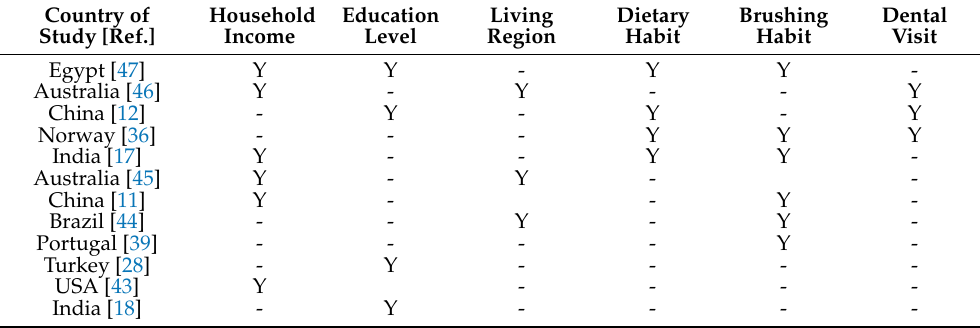
Table 5. Socioeconomic and behavioural factors related to caries assessed in the studies. Country of Study